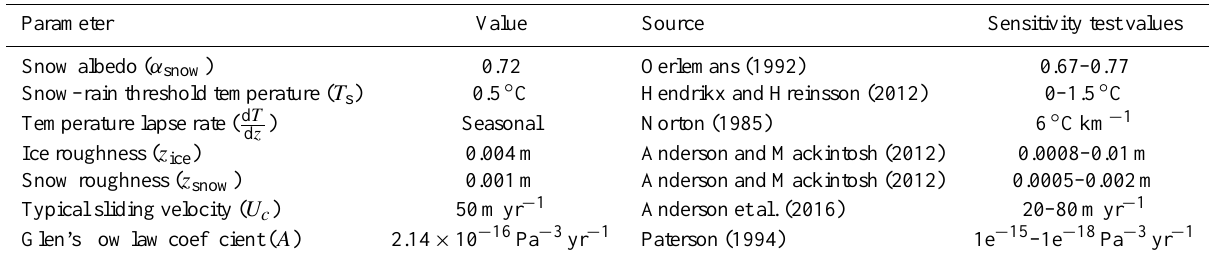
Table 2. Optimal glacier model parameter settings, sources, and sensitivity test